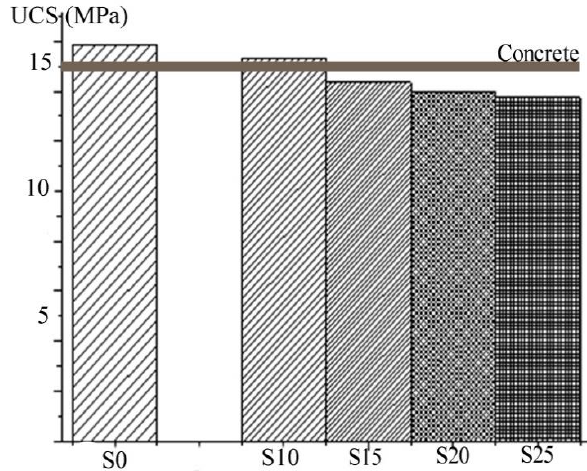
Figure 1. The unconfined compressive strengths of the solidified products S0, S10, S15, S20, S25. The highest UCS (15.32 MPa) (Figure 1) was achieved in the solidified product with minimal